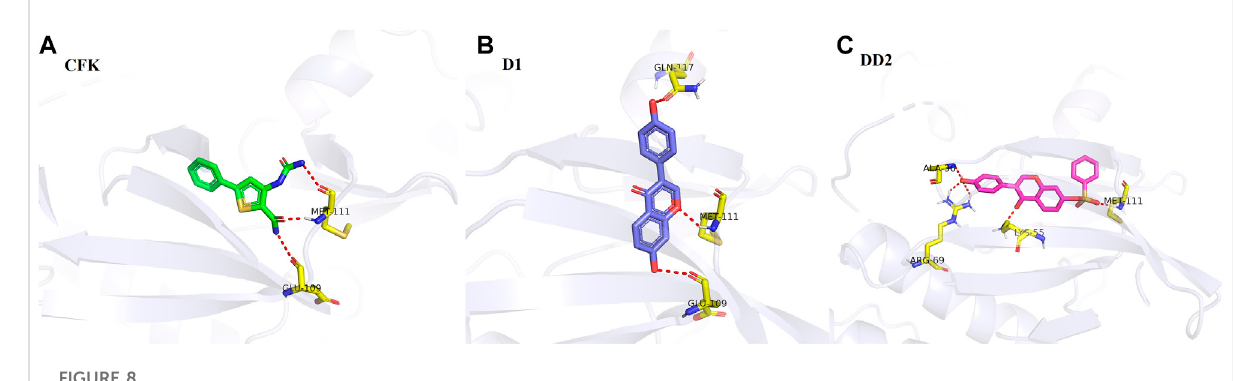
FIGURE 8 Visual results of the docking between ligands and proteins.